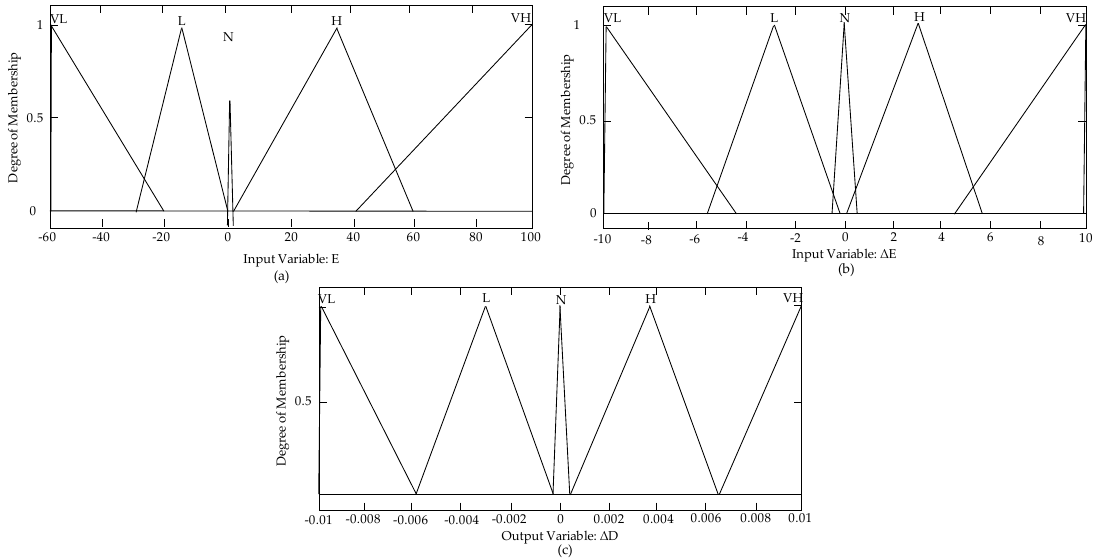
Figure 9. Membership functions. ( a ) Error; ( b ) Change of error; ( c ) Increment of duty cycle.